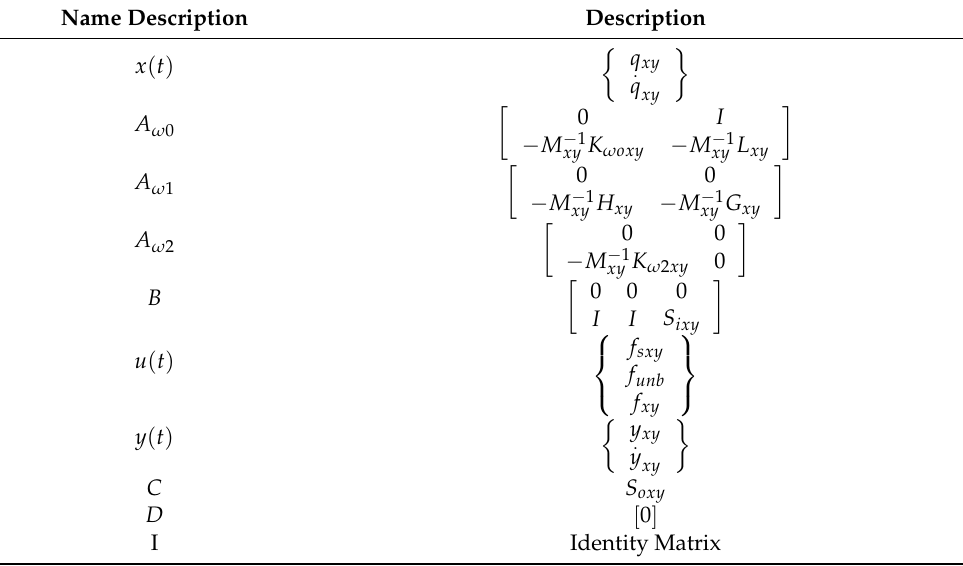
Table 4. Description of the